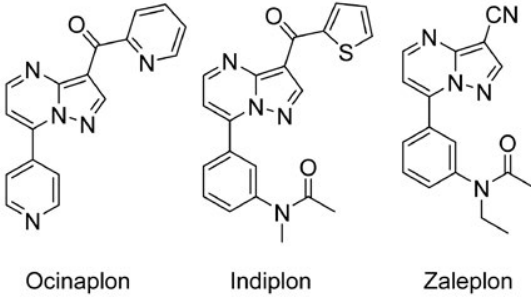
Figure 1. Approved drugs based on a pyrazolo[1,5- a ]pyrimidine